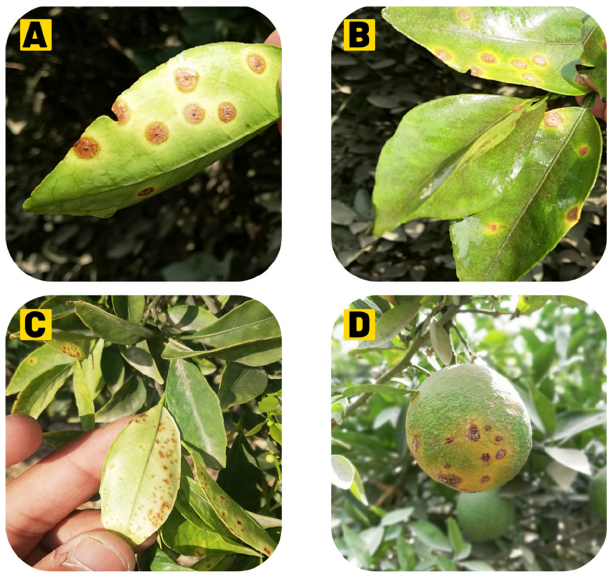
Figure 2. ( A ) Raised, corky, and sunken lesions on the upper side of the leaf. ( B ) Lesions on the lower side of the leaf. ( C ) Initial lesions on the lower surface of the leaf. ( D ) Canker symptoms on the